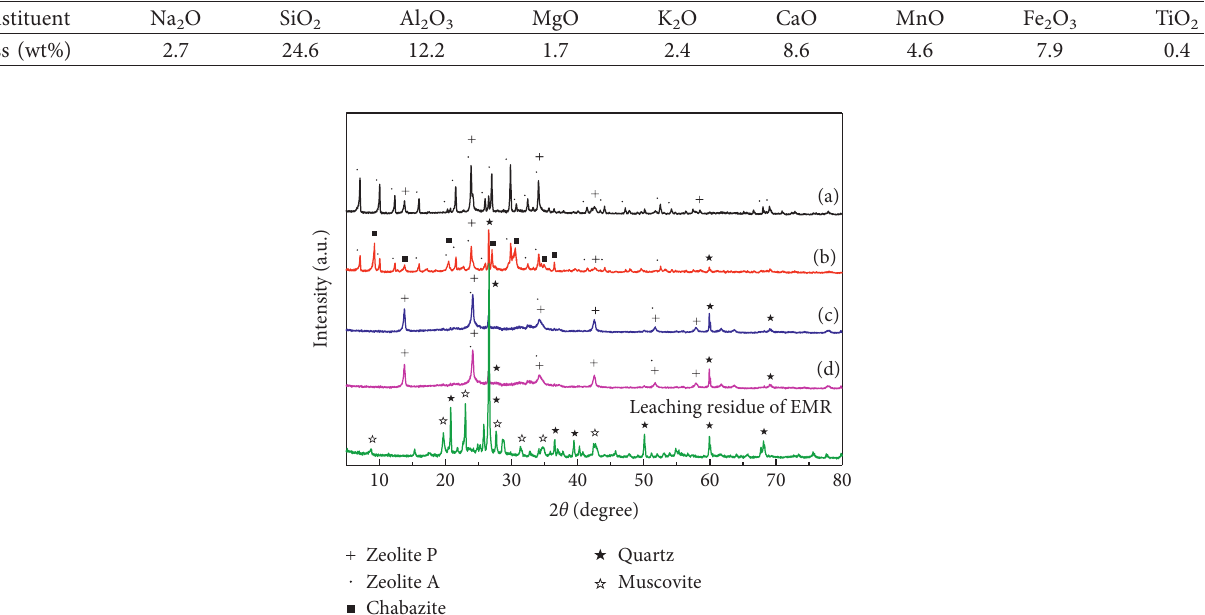
Figure 1: XRD patterns of the synthesized zeolites under various initial Si/Al ratios: (a) 1.5; (b) 2.0; (c) 2.5; (d) 3.0; LR-EMR (synthesis conditions: reaction temperature, 100 ° C; reaction time, 1.0h).